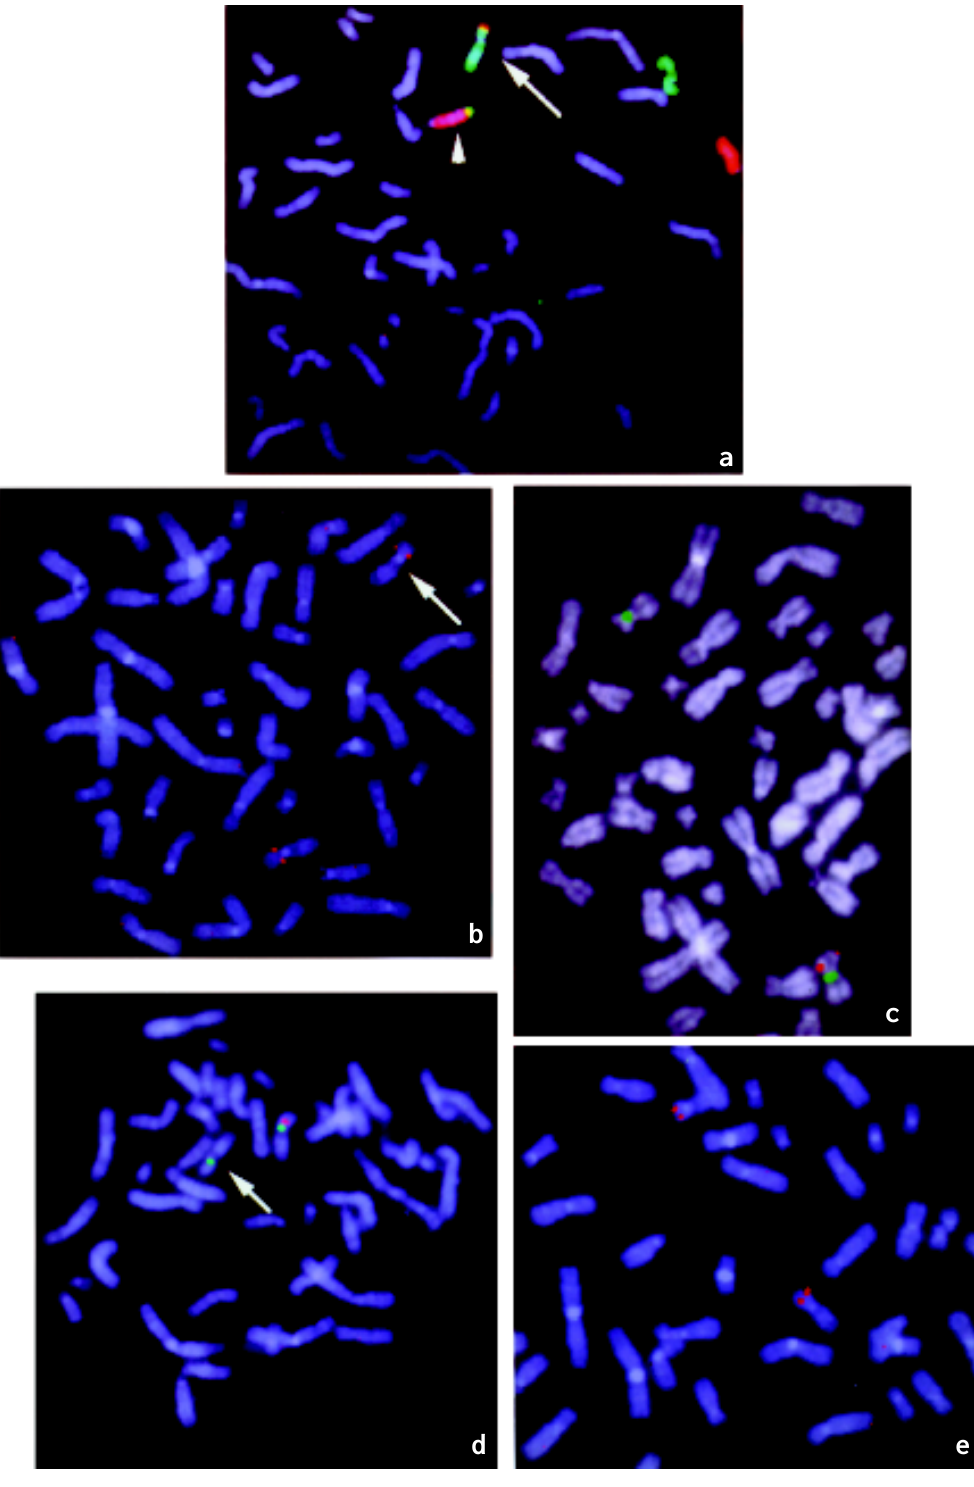
Figure 3 - Examples of the results obtained following FISH with dual colour whole chromosome 11 and 13 paints (a) and locus specific cosmids (b,c,d,e): ( a ) Dual colour painting using a directly FITC-labelled (green) chromosome 11 paint and a biotin-labelled rhodamine-stained (red) chromosome 13 paint. Both the der(11) - arrow - and the der(13) - arrowhead - show clear evidence of a reciprocal exchange of chromatin from distal 11p and distal 13q, respectively. Furthermore, the painting result suggests that the chromatin missing from the interstitial segment of 11p has not been involved in an inter-chromosomal rearrangement (see text). ( b ) Cosmid 1-11-474 which maps to 11p12. Both the normal and der(11) - arrow - show signal with this probe. ( c , d ) Cosmids B2.1 and FAT5 which maps to WT1 and PAX6, respectively. The cosmid signal is red (rhodamine) and the 11 centromeres are identified by the alphoid repeat probe D11Z1 (labelled green with FITC). The der(11) - arrow in d - are deleted for WT1 and PAX6. ( e ) Cosmid F1238 which maps to 11p14.2. Both the normal and der(11) show signal with this